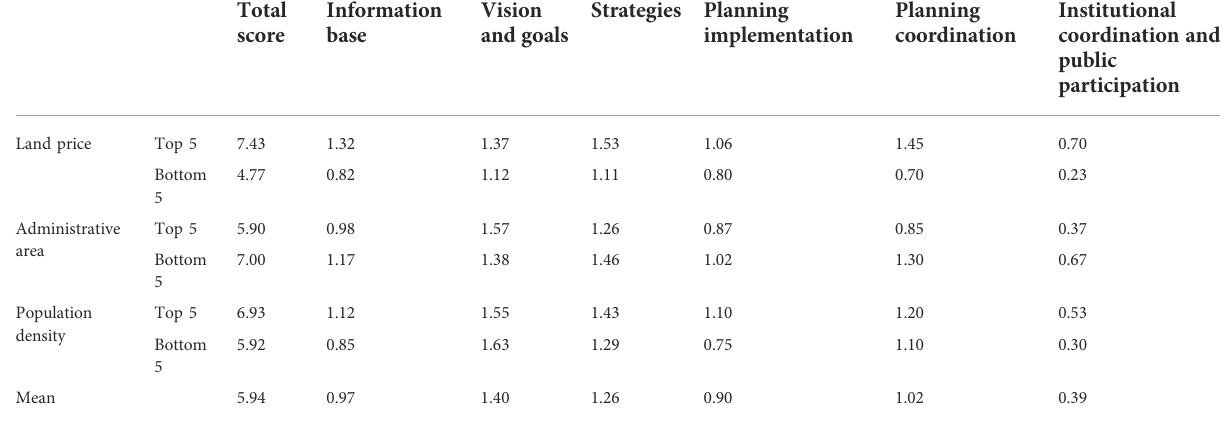
TABLE 2 Scores of top and bottom cities for each in fl uencing